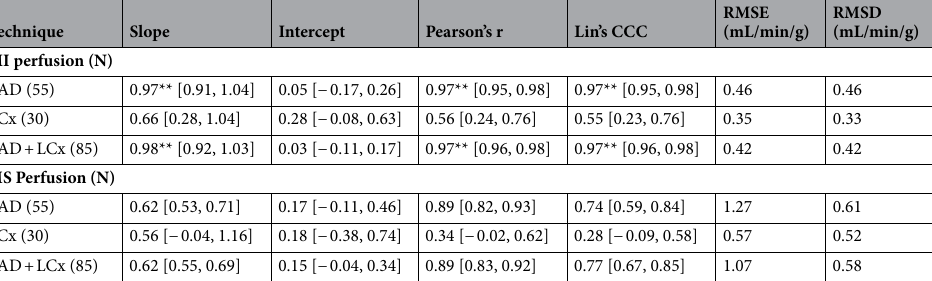
Table 1. Motion-immune (MI) and motion-susceptible (MS) CT perfusion as compared to reference standard microsphere perfusion. Brackets indicate 95% confidence intervals. MI motion-immune CT perfusion, MS motion-susceptible CT perfusion, LAD left anterior descending coronary artery, LCx left circumflex coronary artery, N number of perfusion measurements, Lin’s CCC Lin’s concordance correlation coefficient, RMSE root-mean-square error, RMSD root-mean-square deviation. **Indicates non-overlap of the 95% confidence intervals, i.e., significant differences between corresponding MI and MS